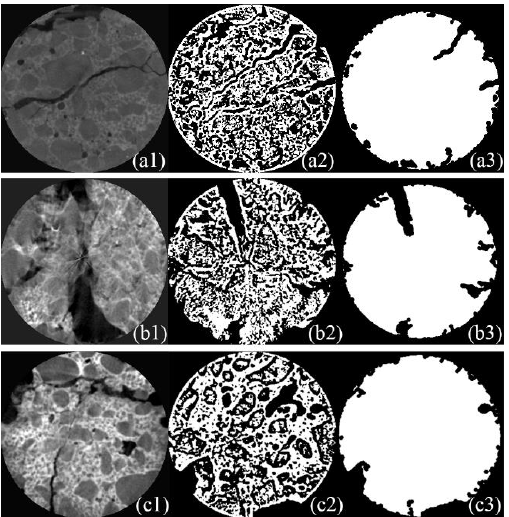
Figure 11. Initial microCT images for mortar-reference ( a 1 ), mortar-SAPs-1 ( b 1 ) and mortar-SAPs-2 ( c 1 ), resulting images for mortar-reference ( a 2 ), mortar-SAPs-1 ( b 2 ) and mortar-SAPs-2 ( c 2 ) and ROI images for mortar-reference ( a 3 ), mortar-SAPs-1 ( b 3 ) and mortar-SAPs-2 ( c 3 ) after adaptive thresholding method and shrink-wrap function are applied after 8 days of healing treatment.